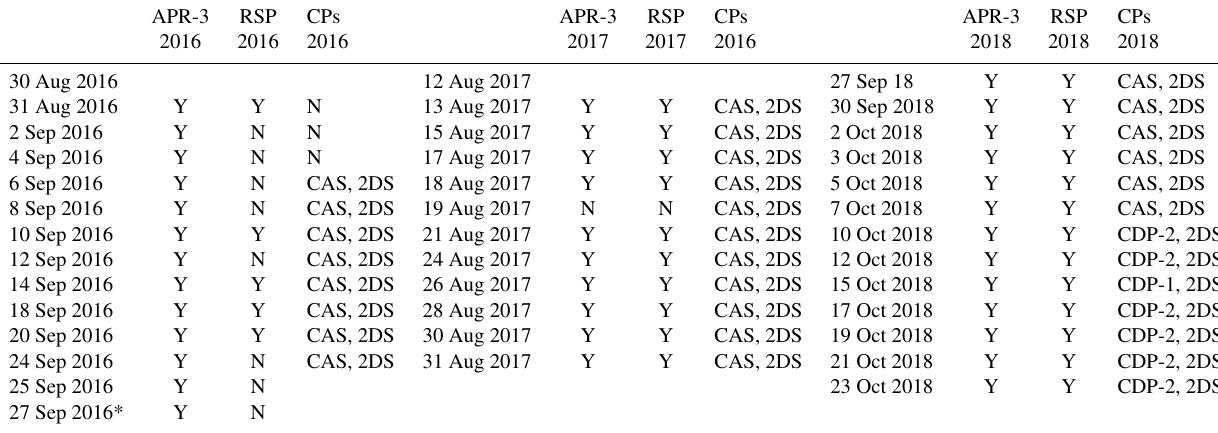
Table 1. Description of data availability for the ORACLES 2016–2018 field campaigns. The 27 September 2016 flight was classified a “transit flight” but is included in this analysis because the transit flight took place entirely in the experiment area between Walvis Bay, Namibia, and Ascension Island and is denoted by a single asterisk (*). No ER-2 data are included in this study. “Y” denotes available data for a given flight, whereas “N” indicates no data available. For the cloud probes (CPs), the instruments used to derive CWP and RWP are